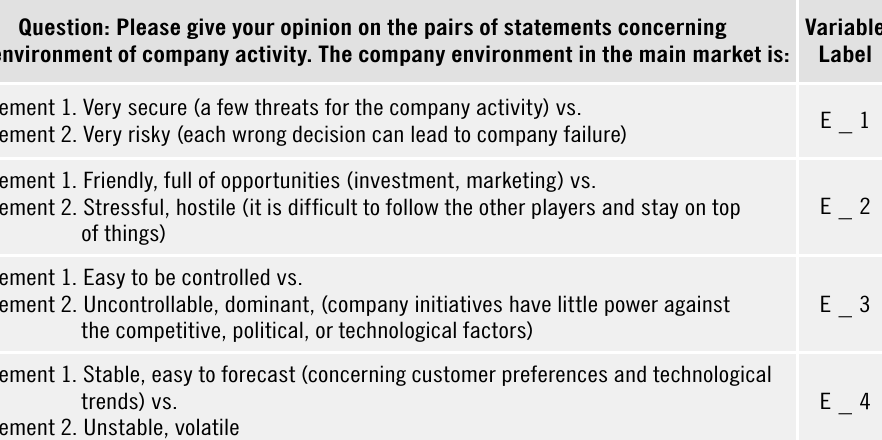
Table 1. Environmental hostility scale’s